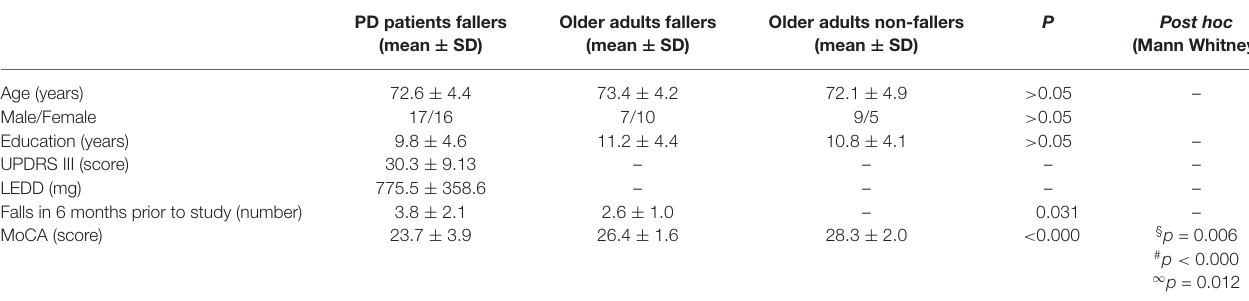
TABLE 1 | Demographics and clinical characteristics of participants